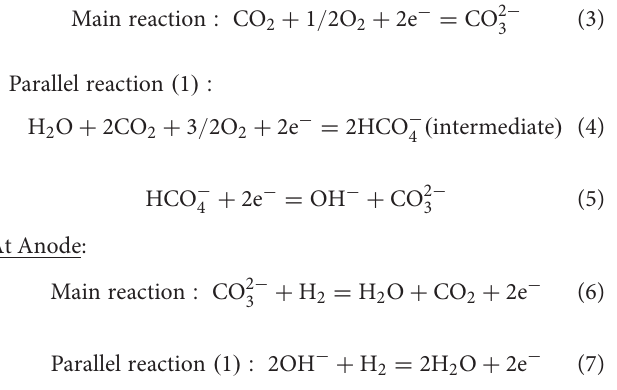
Frontiers in Energy Research |